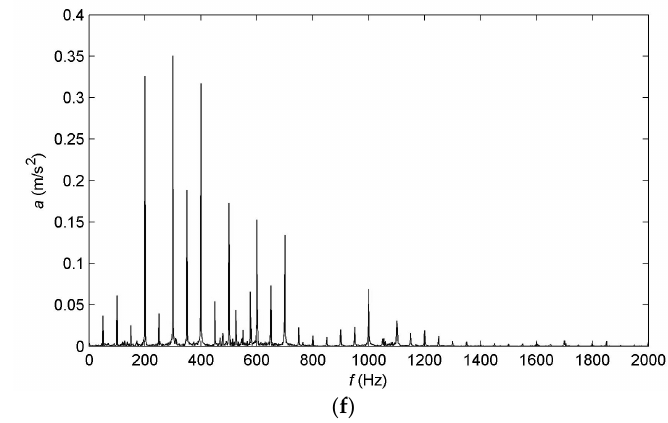
Figure 3. Transformer vibration without DC bias: ( a ) Time-domain waveform of point 1; ( b ) Frequency spectrum distribution of point 1; ( c ) Time-domain waveform of point 2; ( d ) Frequency spectrum distribution of point 2; ( e ) Time-domain waveform of point 3; ( f ) Frequency spectrum distribution of point 3.